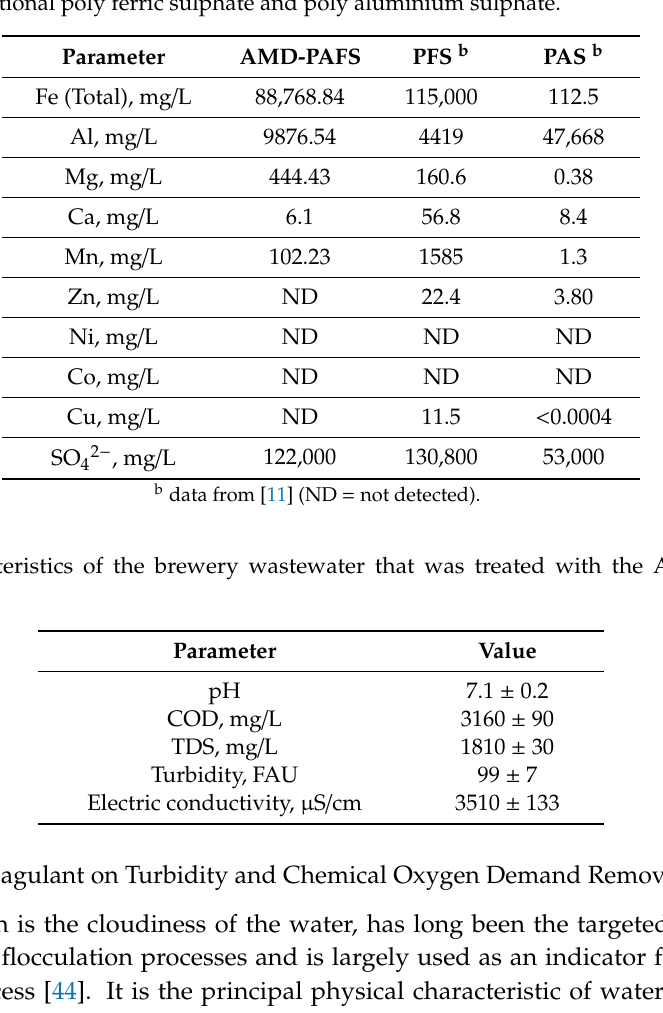
Table 3. Chemical composition of the poly-alumino-ferric sulphate coagulant produced by precipitation at pH and conventional poly ferric sulphate and poly aluminium sulphate.